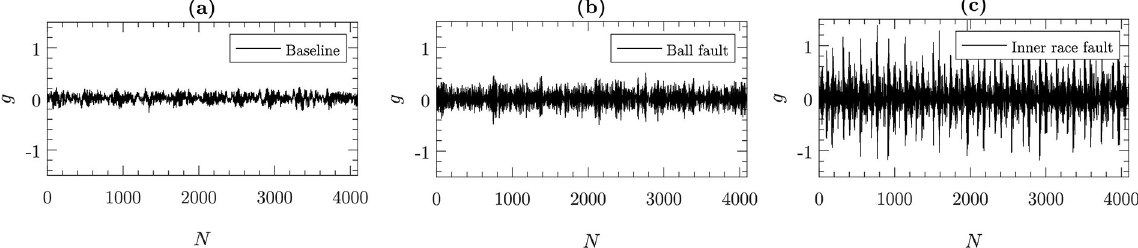
Fig 6. Sample vibration signals representing (a) baseline condition, (b) ball fault, and (c) inner race fault. In this case, the fault diameter for both the ball and inner race is 0.17 mm (0.007 inches), load is 0 kW (0 hp), and rotational speed is 29.95 rps (1797 rpm). The bearing considered is drive-end